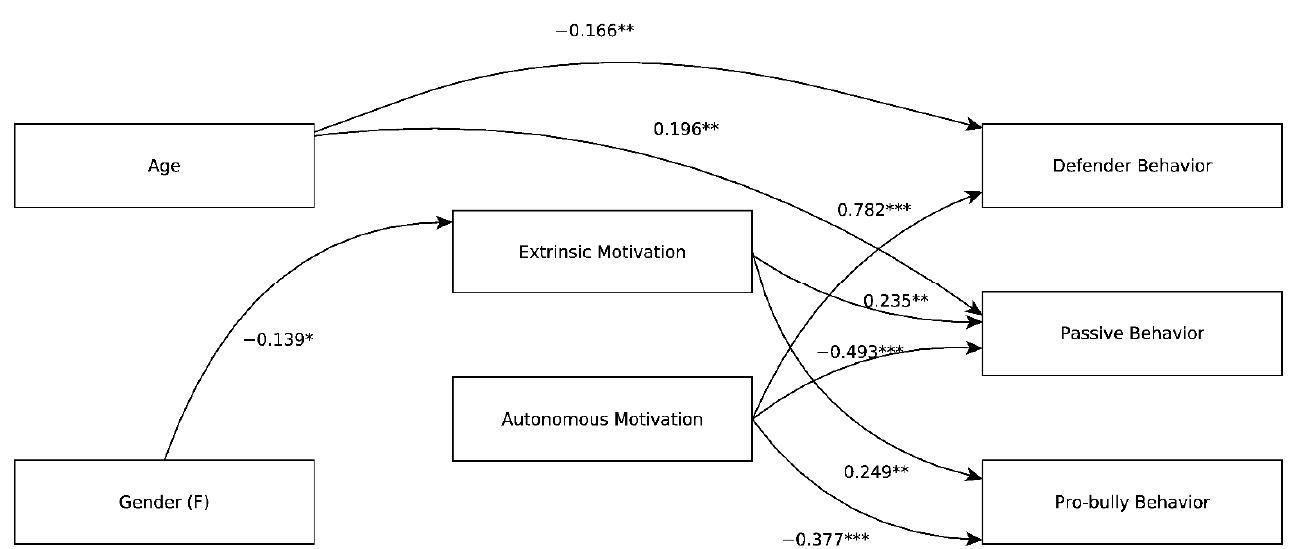
Figure 1. The structural model. ***: p < 0.001; **: 0.001 < p < 0.01; *: 0.01 < p < 0.05; only significant effects ( p < 0.05) are shown.